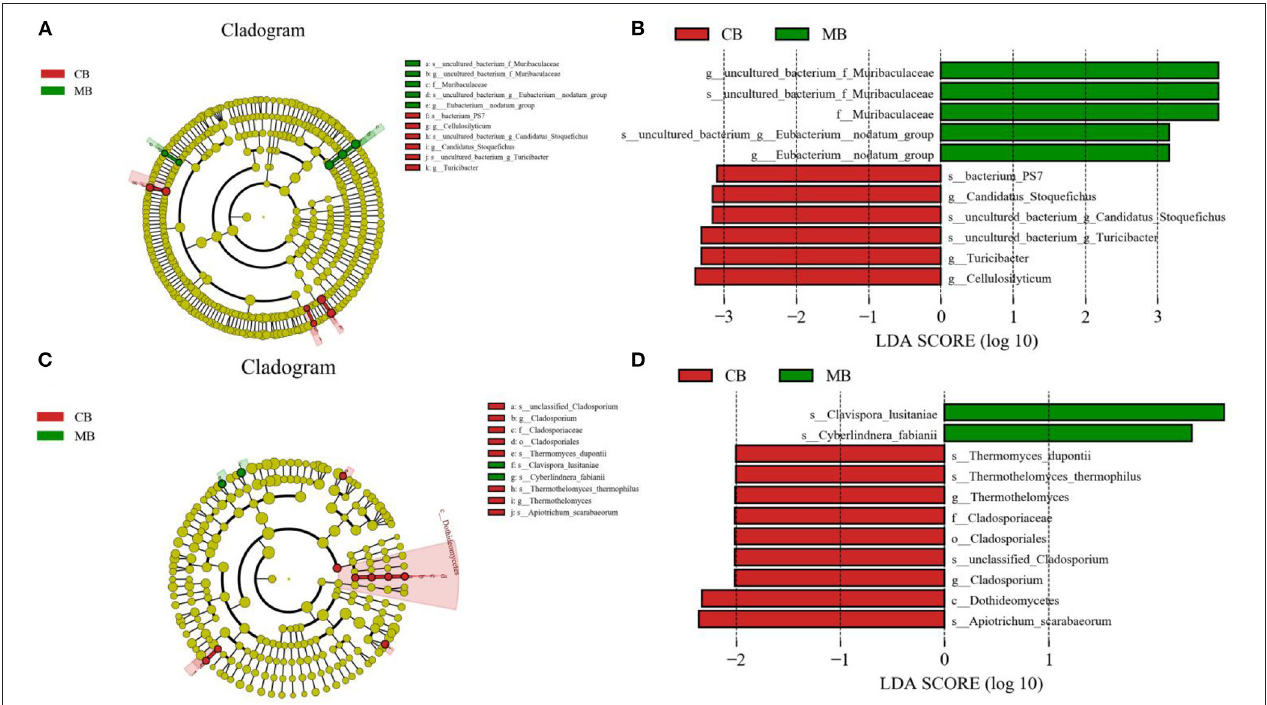
FIGURE 6 | Recognition of differential taxa associated with mastitis in buffalo. Phylogenetic distribution of bacterial (A) and fungal (C) taxa with obvious differences were visualized through the cladogram. The criterion of bacterial (B) and fungal (D) significance was performed at LDA scores >